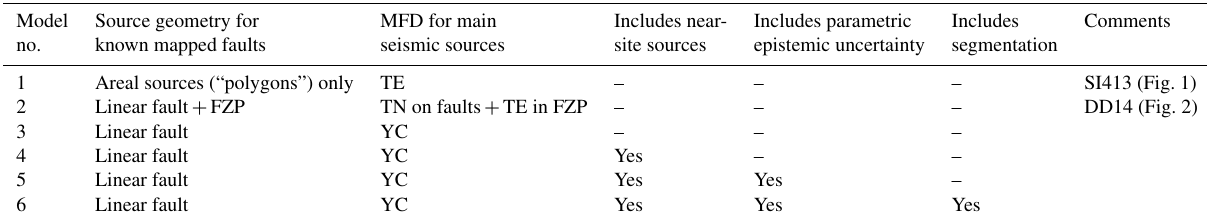
Table 1. List of all seismotectonic models used for analysis in this study and their main features. Model